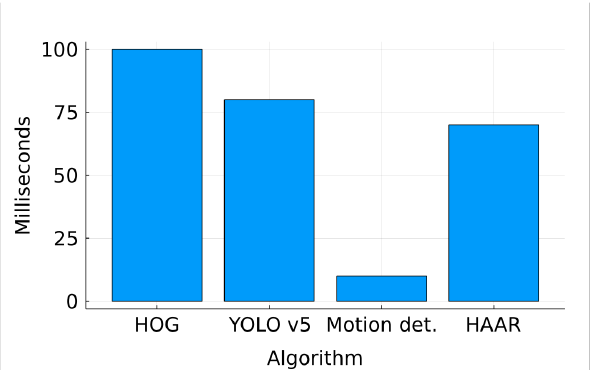
Figure 2. Processing time of each algorithm for a single frame in the